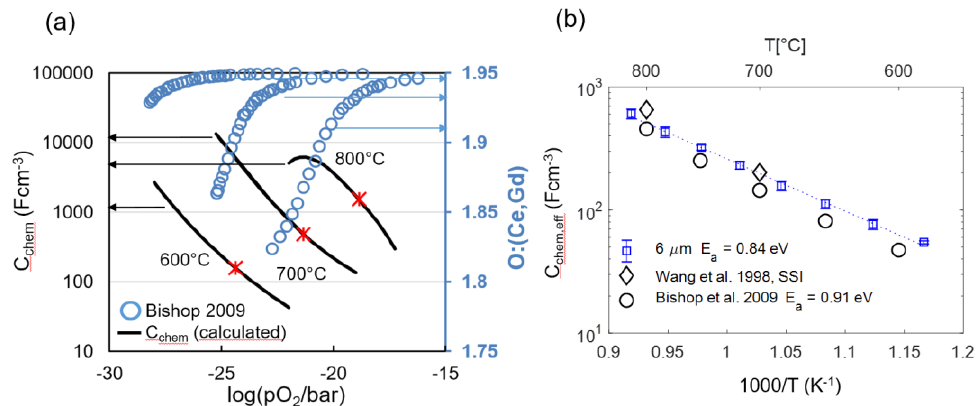
Figure 10. ( a ) Literature values for oxygen nonstoichiometry of GDC10 at 600, 700 and 800 °C (blue circles; right y-axis) by Bishop et al. [51] and chemical capacitance, calculated from the first derivative of the nonstoichiometry isotherms by Equation (16) (black lines; left y-axis). Red stars symbols represent the oxygen partial pressures corresponding to the EIS testing conditions in the present work. ( b ) Fitted effective chemical capacitance of the electrodes as a function of temperature in comparison with calculated chemical capacitance derived from literature nonstoichiometry data by Bishop [51] and Wang [50] and a GDC volume fraction of 0.3.